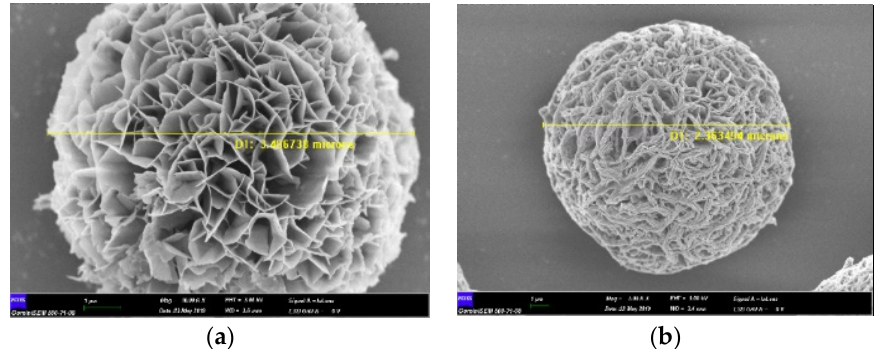
Figure 1. SEM images of xo-Cu 2+ hNFs synthesized at different incubation temperatures ( a ) +4 °C, ( b ) Room